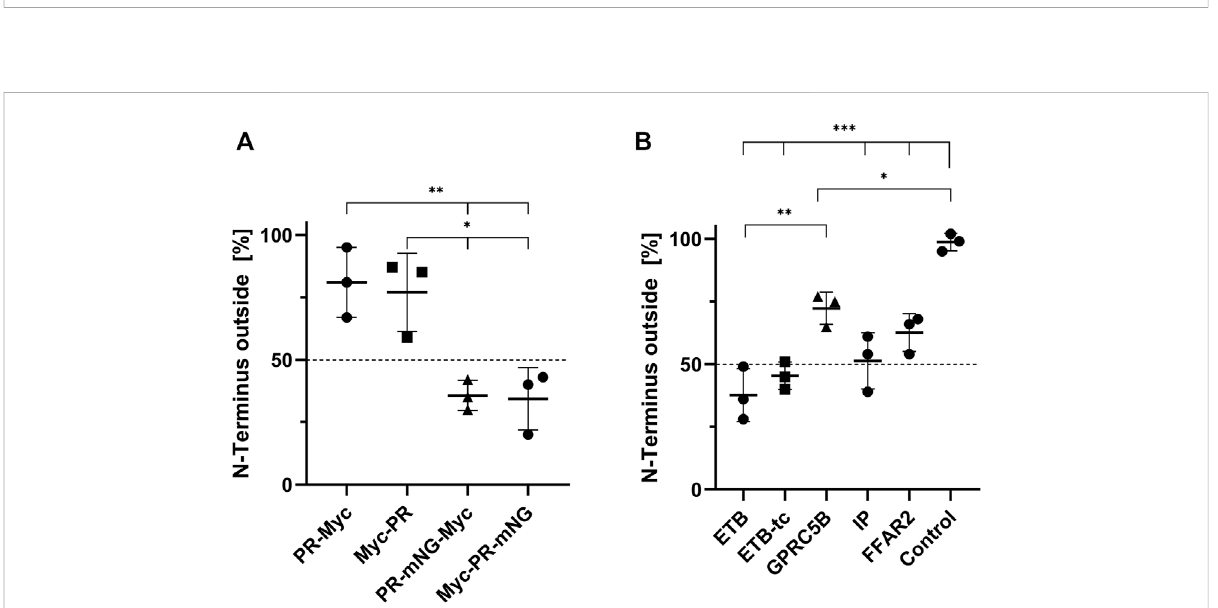
Orientation of transferred MPs in HEK293T cell membranes. NDs containing Myc-tagged MPs were transferred into HEK293T cells at standard conditions. Thecellswere fi xedandeitherpermeabilizedwith0.2%TritonX-100orleftwithintactcellularmembranes.Anti-Mycimmunostainingof permeabilized cells resulted in staining of all transferred MPs, while in non-permeabilized cells only MPs with an extracellularly accessibly Myc-tag were stained. The membrane fl uorescence was quanti fi ed accordingly and the fraction of N-terminally accessible MPs was calculated by dividing the intensity of permeabilized by the intensity of non-permeabilized cells. (A) Membrane topology of transferred PR derivatives from NDs (POPG). (B) Membrane topology of transferred N-terminally Myc-tagged GPCRs. The transfer mixtures contained Myc-ETB/NDs,